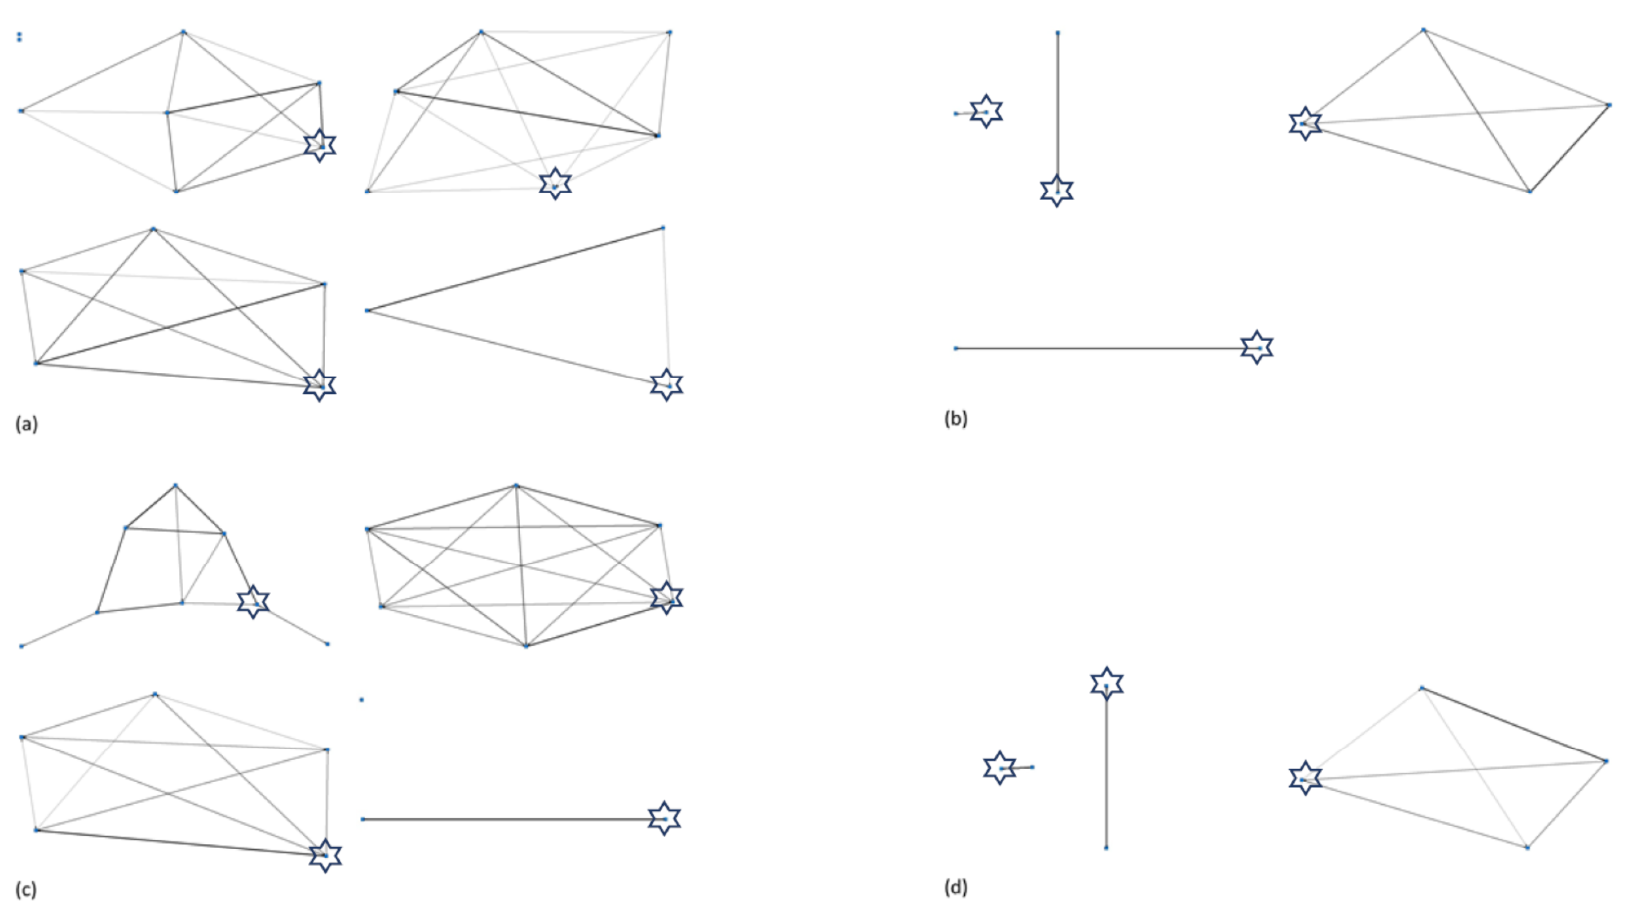
Figure 1. Sociograms depicting negative interaction networks in the study elephants. ( a ) Asian elephant negative non-physical interaction network, ( b ) African elephant negative non-physical interaction network, ( c ) Asian elephant negative physical interaction network, and ( d ) African elephant negative physical interaction network. Matriarch or elephant considered to be the most dominant herd member is highlighted with a star.